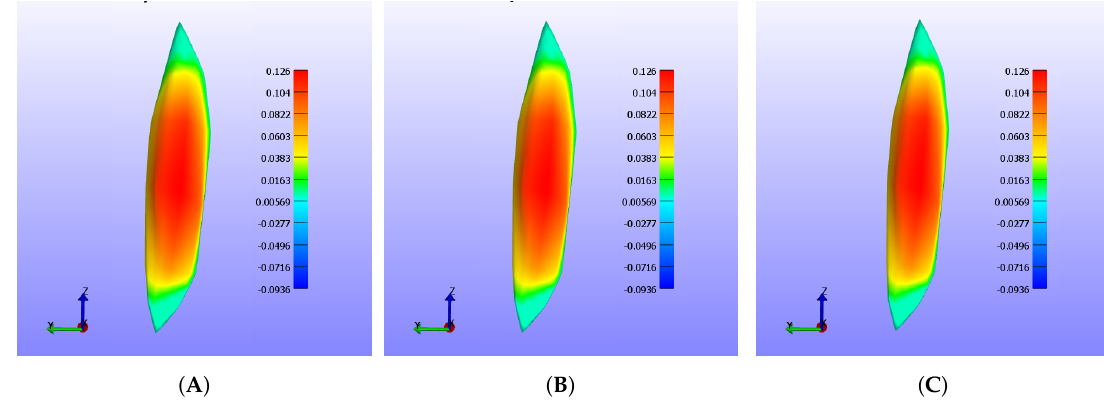
Figure 5. FEM based tissue model for the vastus lateralis. ( A ) shows the initial state of the tissue, ( B ) shows the muscle after being innervated, and ( C ) shows the muscle after the current is